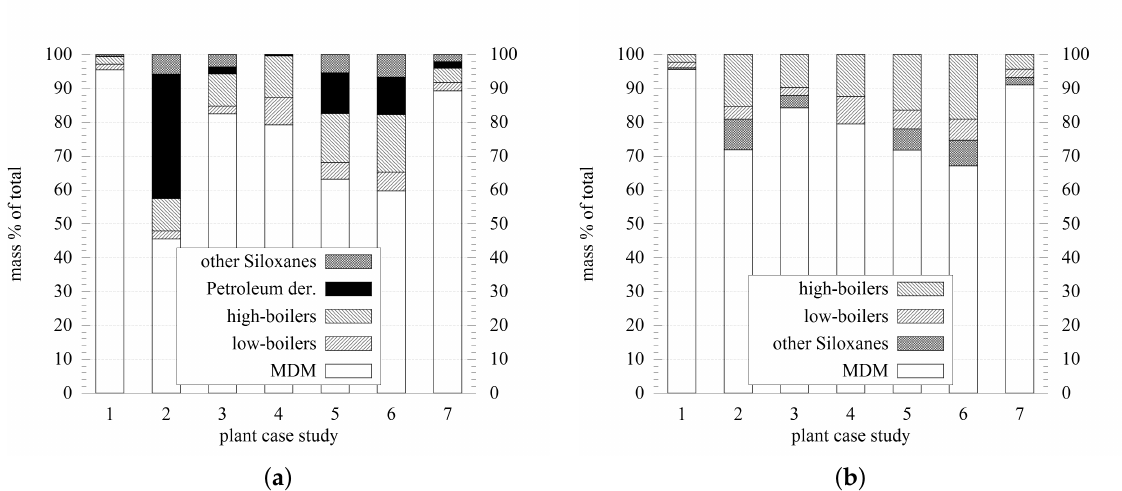
Figure 2. ( a ) Composition of case study fluids including contamination; ( b ) Composition of case study fluids, siloxane fractions